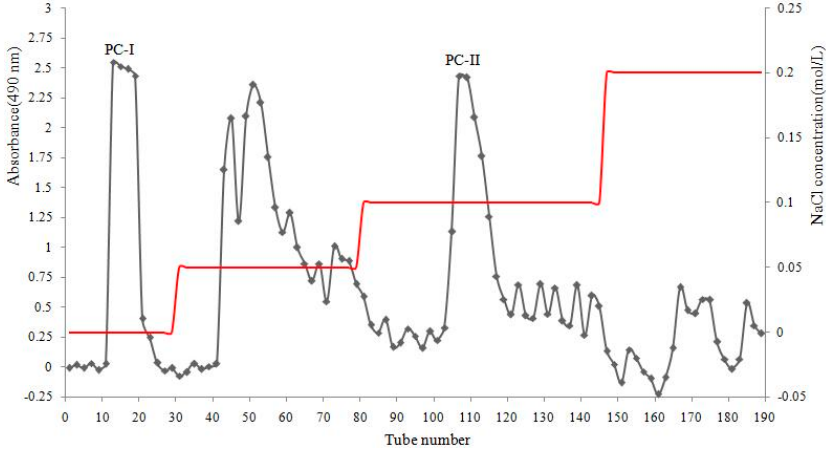
Figure 1. DEAE-52 chromatography of crude polysaccharide from P. corylifolia.